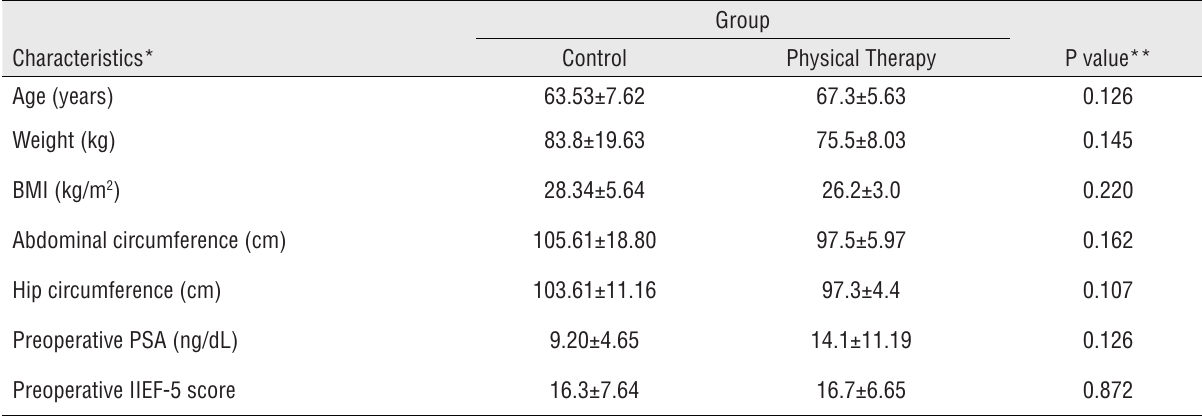
Table 1 - Baseline general characteristics of men submitted (Physical Therapy Group) or not submitted (Control Group) to pelvic floor muscle training before and after radical